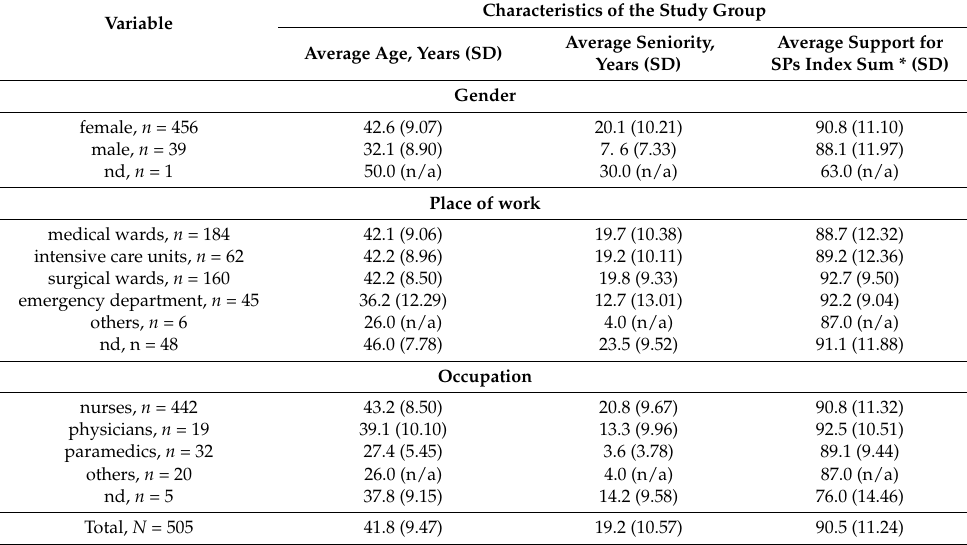
Table 1. The demographic characteristics of the study group and support/acceptance for applying the rules of standard isolation precautions